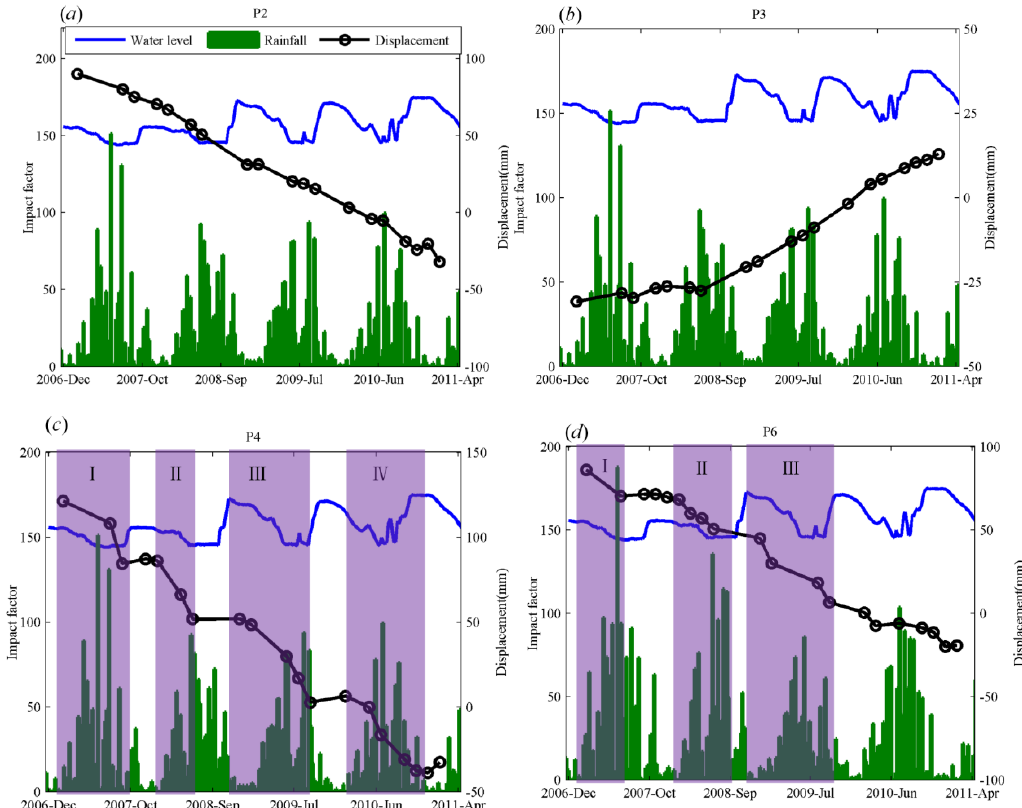
Figure 11. Relationship between impact factors and displacements on ( a ) P2; ( b ) P3; ( c ) P4; ( d ) P6. The measurement units are meter for water level and millimeter for rainfall separately.